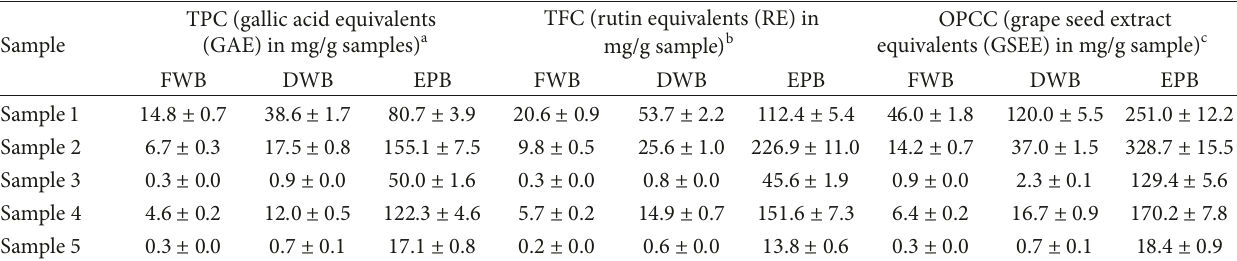
Table 1: Total polyphenol (TP), total flavonoid (TF), and oligomeric proanthocyanidins (OPC) content of five fractions from C. multiflorus sarcocarp (values are mean ± SD of three replicate determinations).